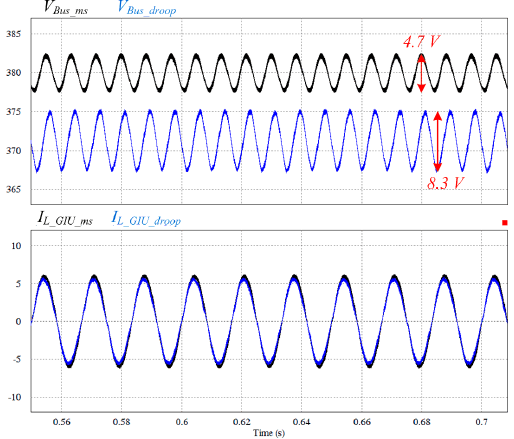
Figure 8. Steady ‐ state simulation comparisons between a conventional droop control method and the proposed master–slave control method.